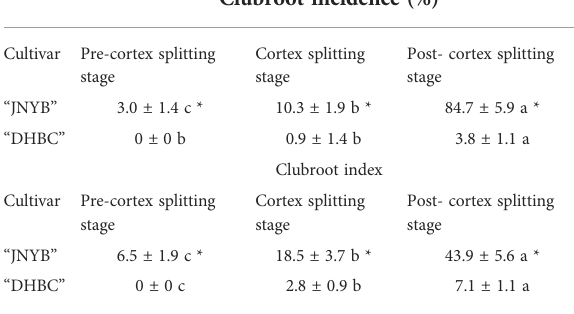
TABLE 1 Assessment of cultivar resistance to P. brassicae Race 4 in different growth stages. Clubroot incidence